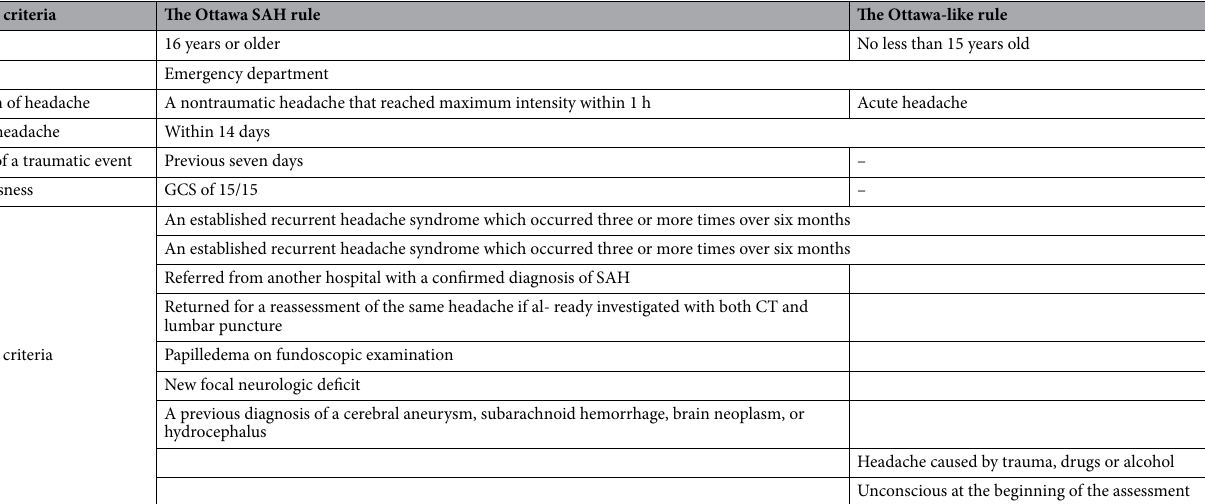
Table 1. The inclusion and exclusion criteria of the Ottawa subarachnoid hemorrhage rule and the Ottawa- like rule. GCS, Glasgow Coma Scale; SAH, Subarachnoid